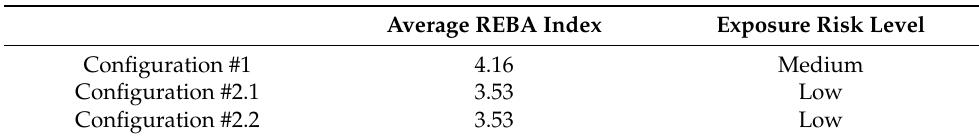
Table 6. Experimental campaign results for the three analyzed configurations, Rapid Entire Body Assessment (REBA) index [pts].